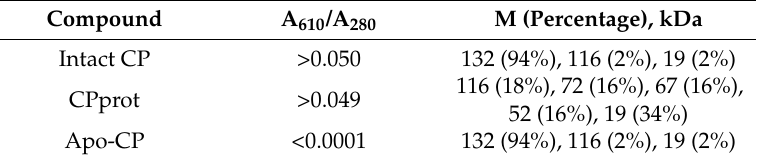
Table 1. Quantitative evaluation of protein preparations.